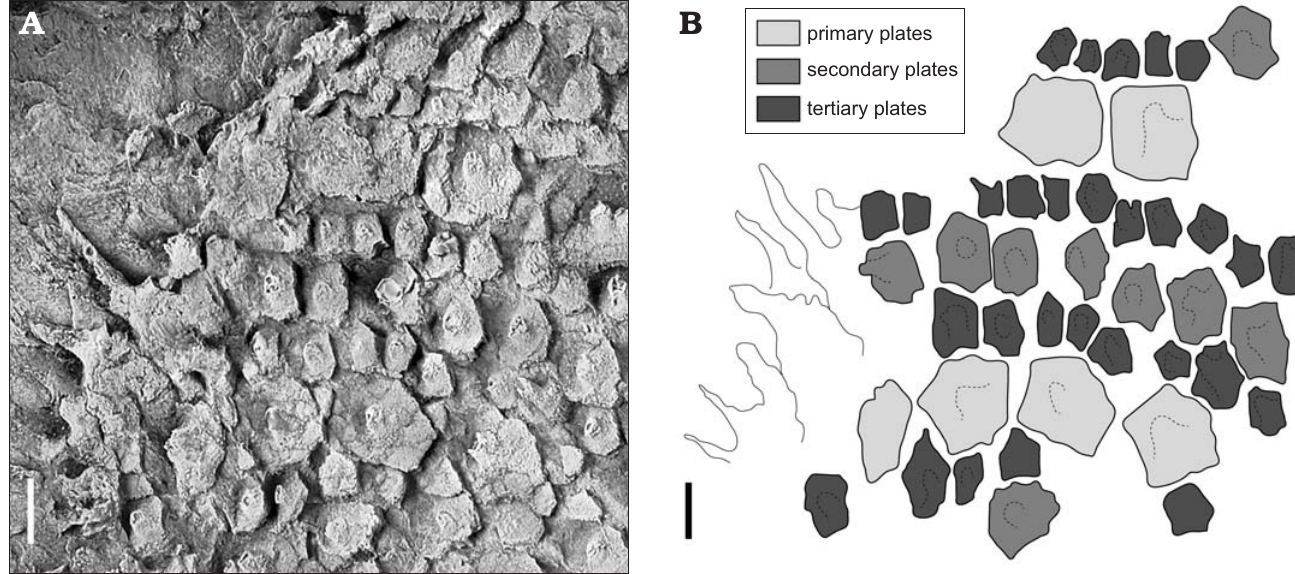
Fig. 4. Diploporite blastozoan Lepidocalix pulcher Termier and Termier, 1950a (MUA. 1023001); Middle Ordovician, Stita, Algeria. A . Photograph of latex cast of external mould showing spines, tubercles, and the appearance of imbricate plates. B . Camera lucida drawing, note three generations of plates. Scale bars 2